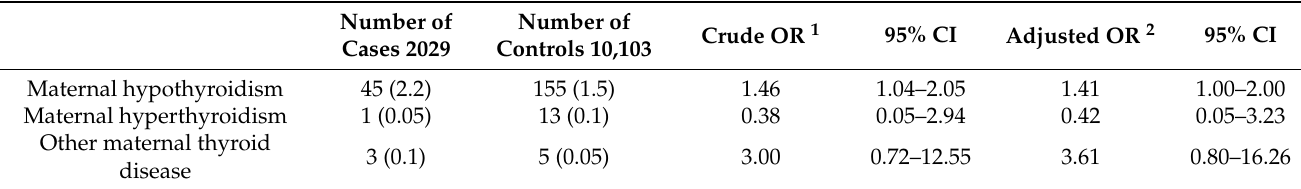
Table A1. Sensitivity analysis for maternal thyroid disease and the risk of childhood cancer in the offspring, including birth weight in the